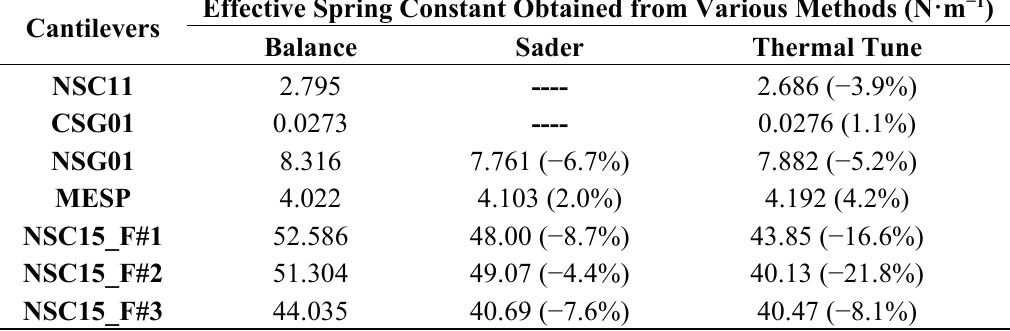
Table 6. Comparison of calibration results with different